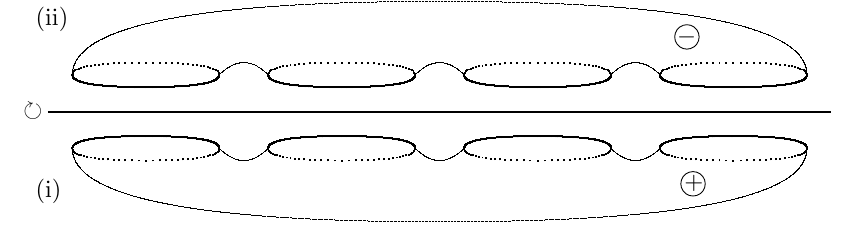
Figure A2. The action of j on M